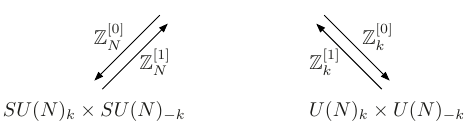
Figure 1 . The discrete gauging relations between the three basic 3d